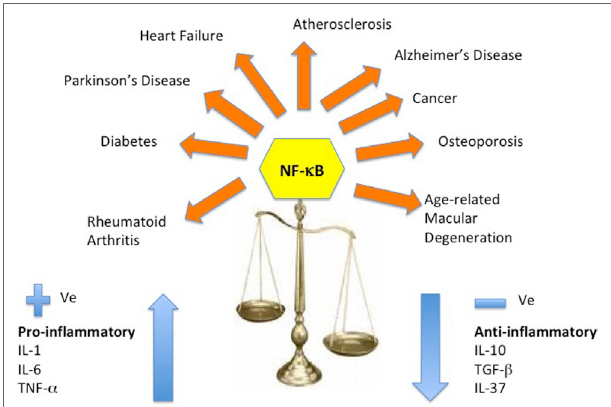
FigURe 5 | Cytokine dysregulation and NF- κ B inflammation pathway. This reshaping of cytokine expression pattern with a progressive tendency toward a pro-inflammatory phenotype has been called “inflamm-aging” and is found associated with age-related diseases. Several molecular pathways have been identified that trigger the inflammasome and stimulate the NF- κ B and the IL-1 β -mediated inflammatory cascade of